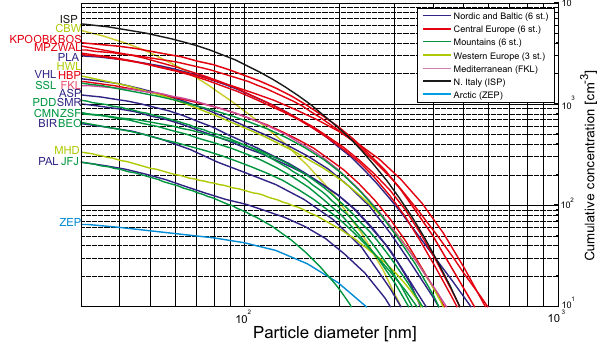
Fig. 14. Cumulative number concentration of the median size distri- butions at EUSAAR and GUAN stations. The summation was done starting from the largest available size. The plot shows how much particles were above each diameter in the median size distribution